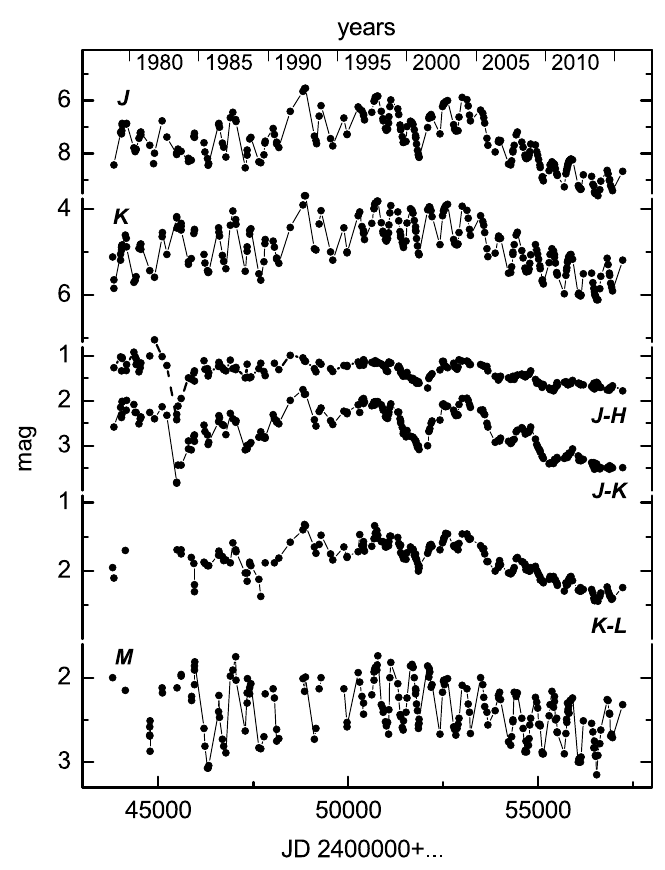
Fig. 3. JKM light and J (cid:21) H , J (cid:21) K , K (cid:21) L color curves for V1016 Cyg in 1978(cid:21)2015.